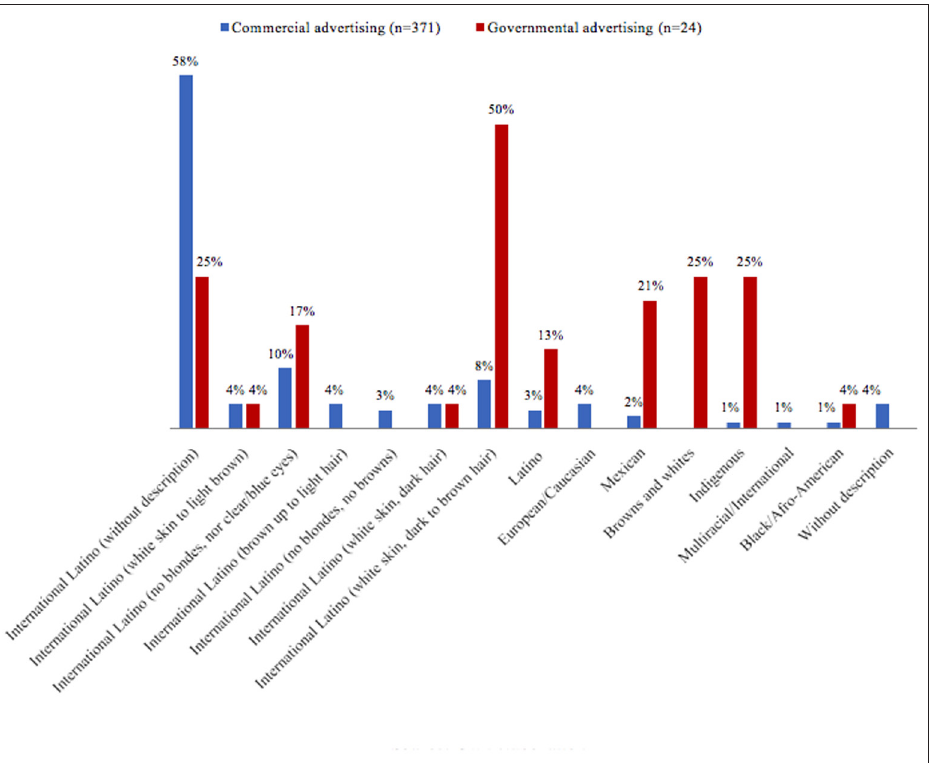
Figure 3: Requested phenotypes in advertising for Mexico. Source: Own